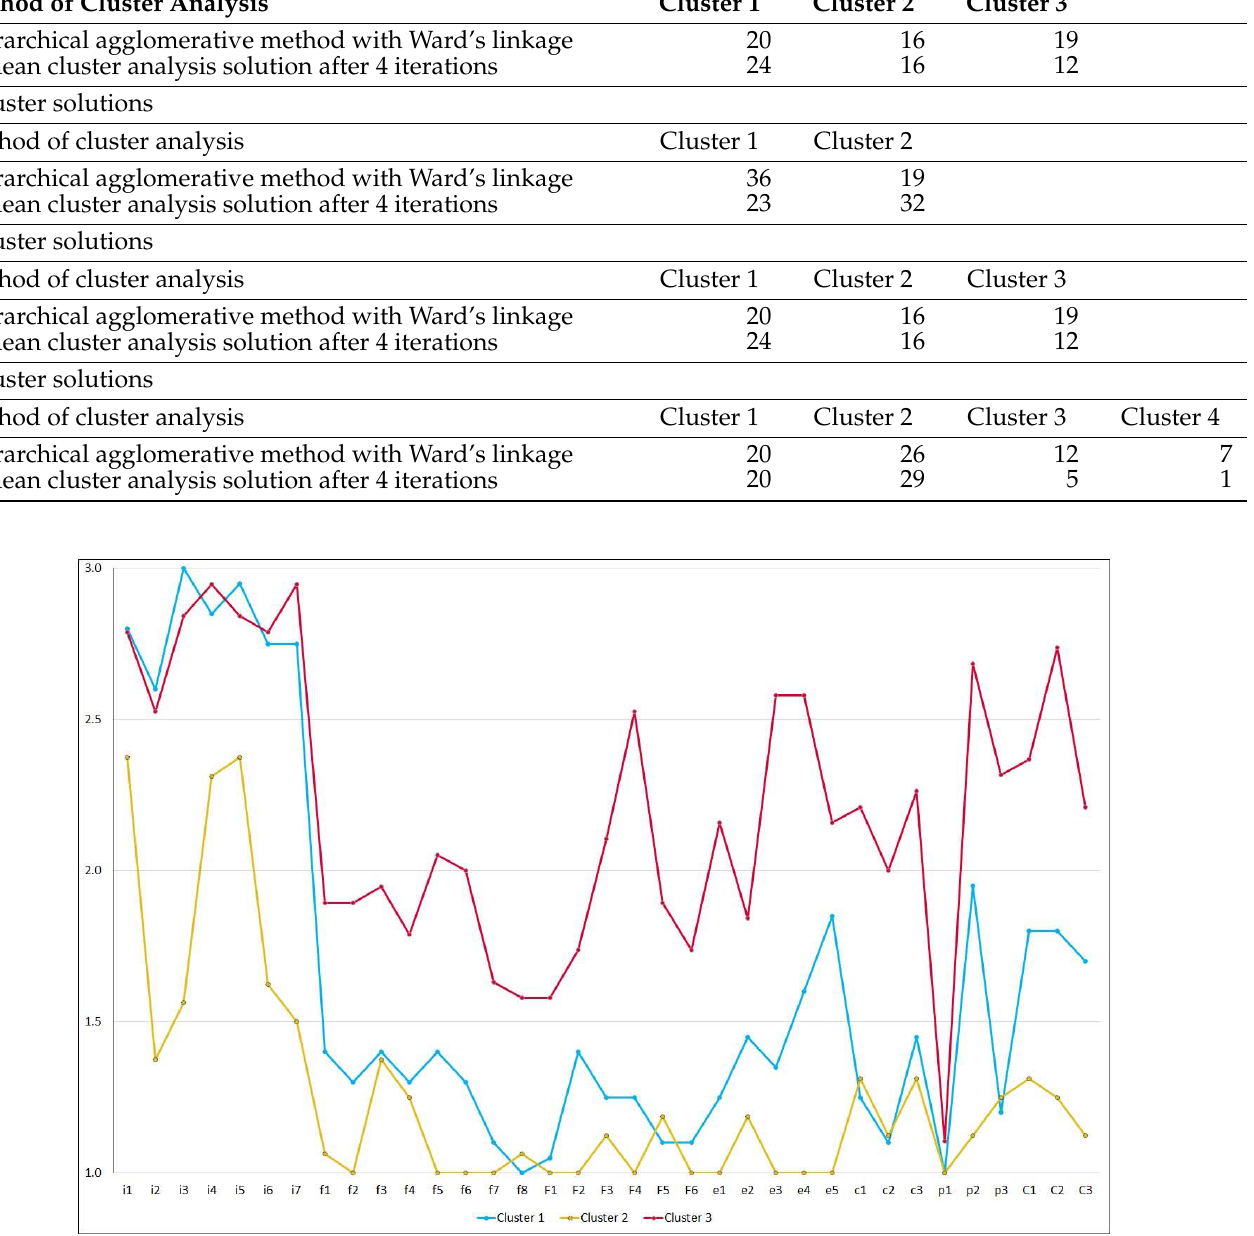
Figure 2. Three unique needs profiles of the final three-cluster solution based on the mean scores for each need item in the Family Needs Survey.